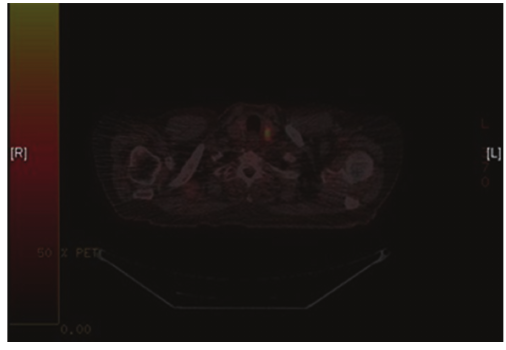
Figure 2: PET image showing thyroid